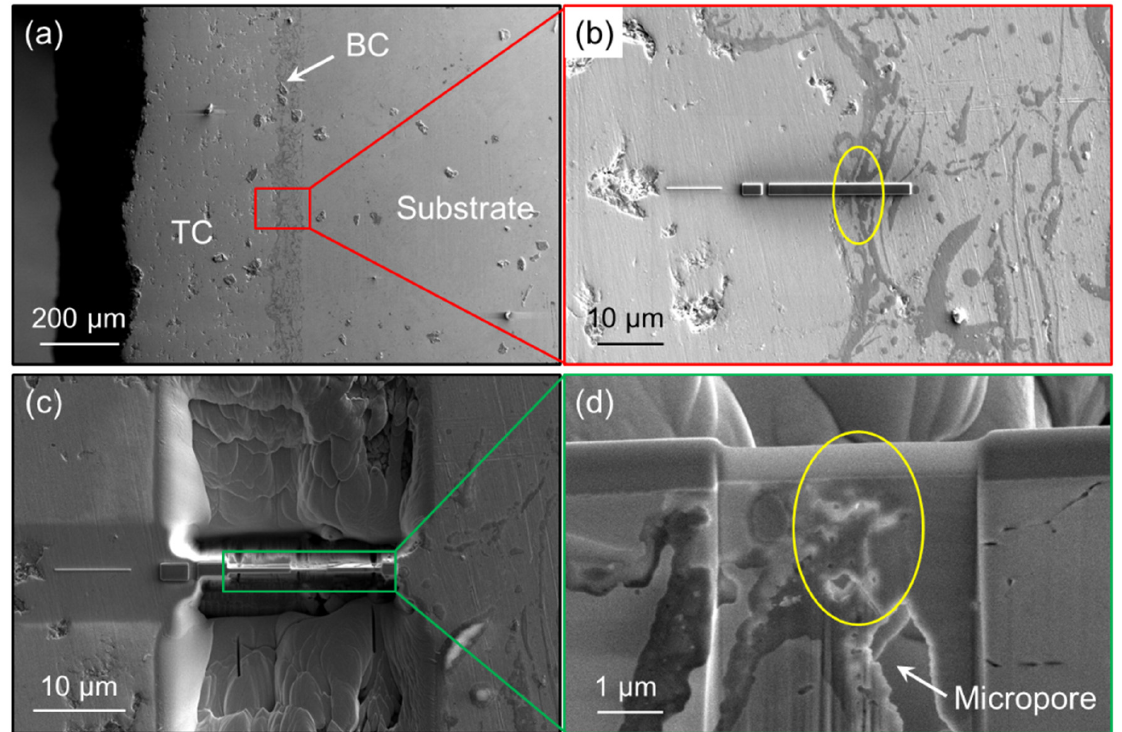
Figure 2. TBCs TEM sample preparation process using FIB-EB double-beam system: ( a ) Sample overview; ( b ) Depositing Pt; ( c ) Front view of the prepared TEM sample; and ( d ) Side view of the TEM sample’s thin area.